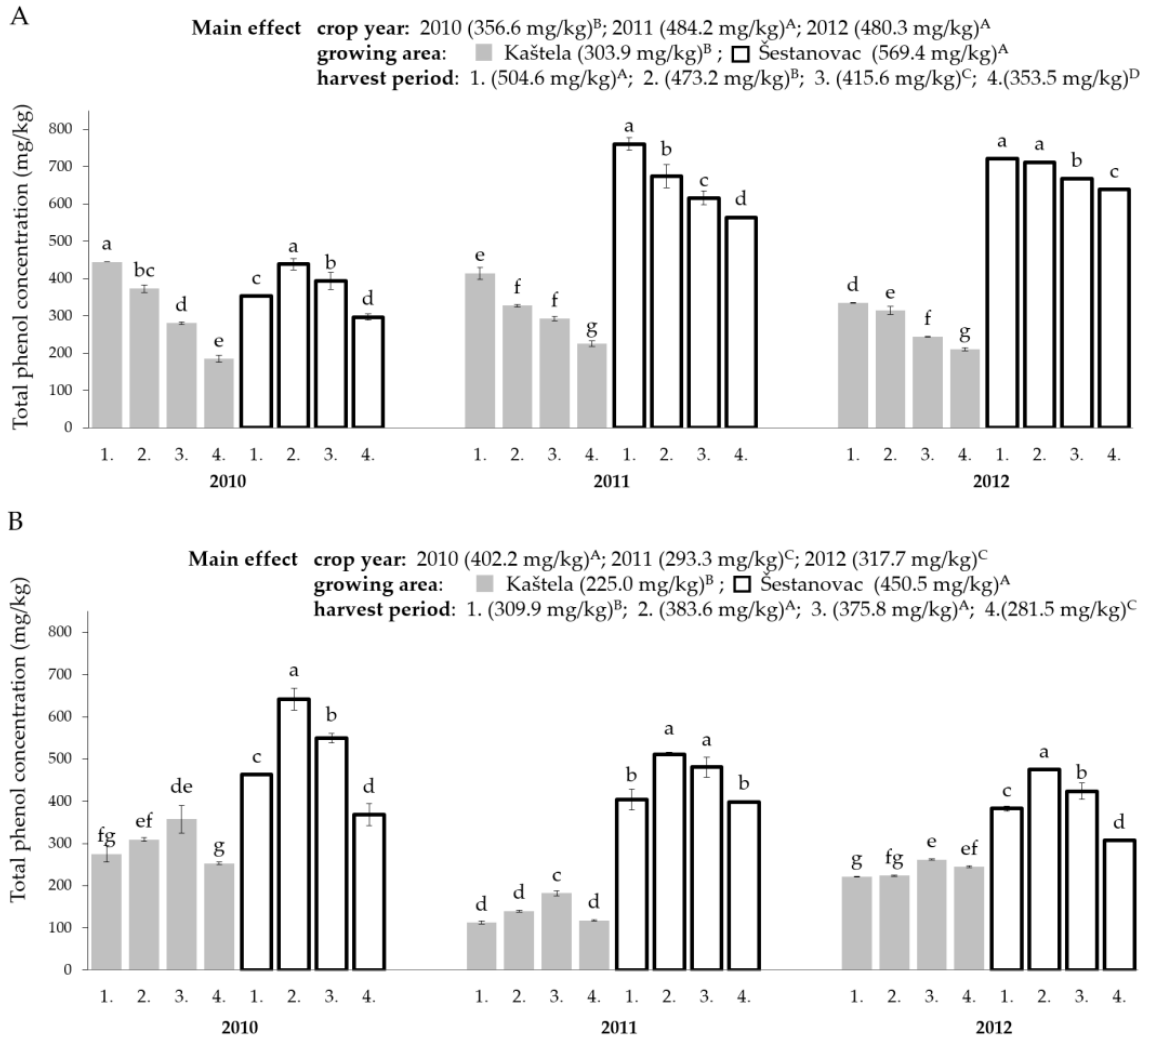
Figure 2. Total phenol concentration (mg/kg) of Oblica ( A ) and Leccino ( B ) virgin olive oils during ripening, obtained from two distinct olive orchards (Kaštela and Šestanovac) in three successive crop years. Bars labelled by different lowercase letters, for each crop year, are significantly different, while different uppercase letters indicate differences within main effects (crop year, growing site and harvest period), obtained by three-way ANOVA (Tukey’s test, p ≤ 0.05). 1–4, harvest period, see also Table 1.